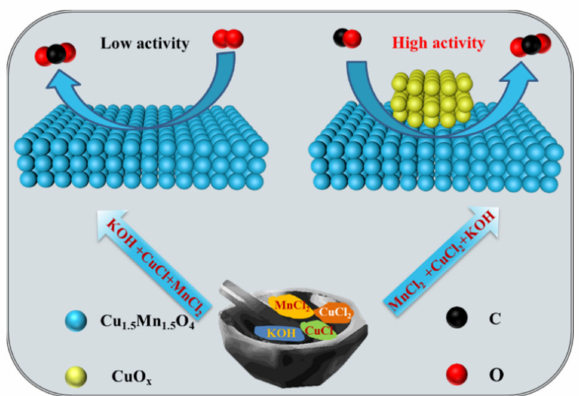
Figure 9. Reaction mechanisms of CuO x /Cu 1.5 Mn 1.5 O 4 toward CO